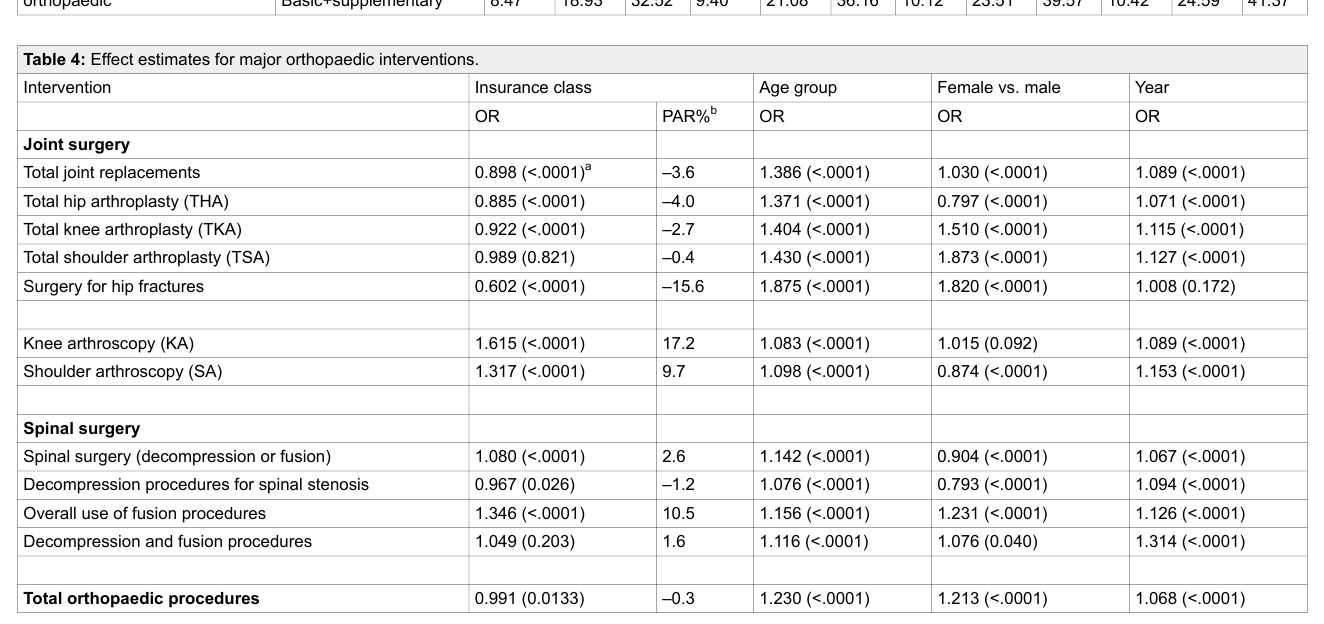
Table 4: Effect estimates for major orthopaedic